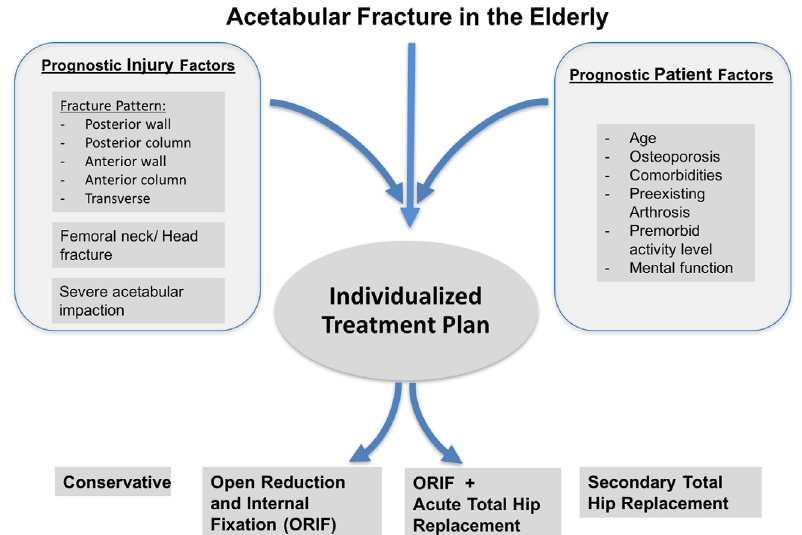
Figure 5. Algorithm for individualized treatment of acetabular fractures in the elderly. Prognostic injury and patient factors have to be considered prior to determining the treatment.